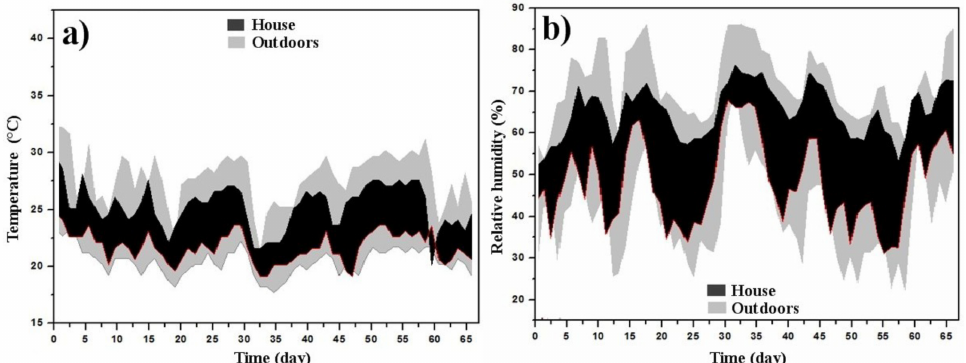
Figure 7. Bimonthly graphs of the behavior of the conventional house for ( a ) temperatures and ( b ) relative humidities.